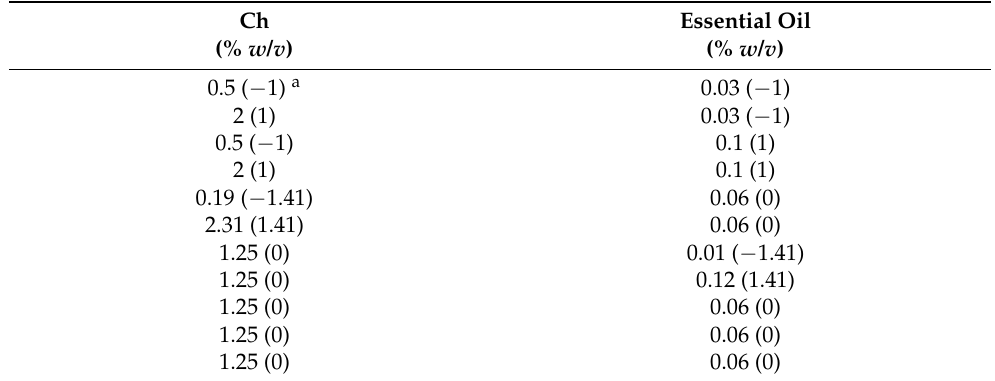
Table 1. Composition of chitosan (Ch) and essential oil (TO, FO or OO) coating formulations containing 2% GTE according to the CCRD